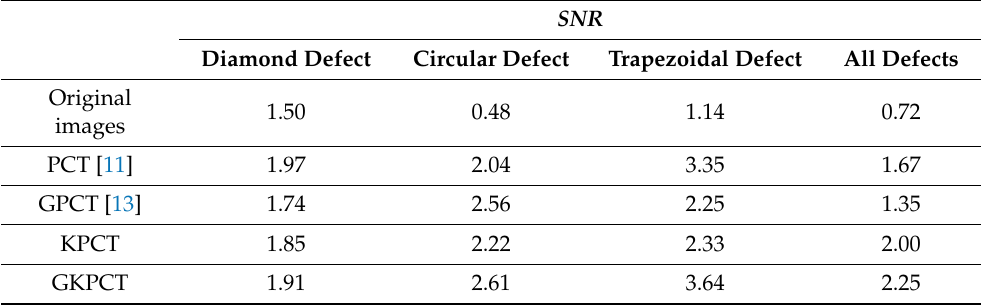
Table 1. SNR values of different methods for CFRP specimen